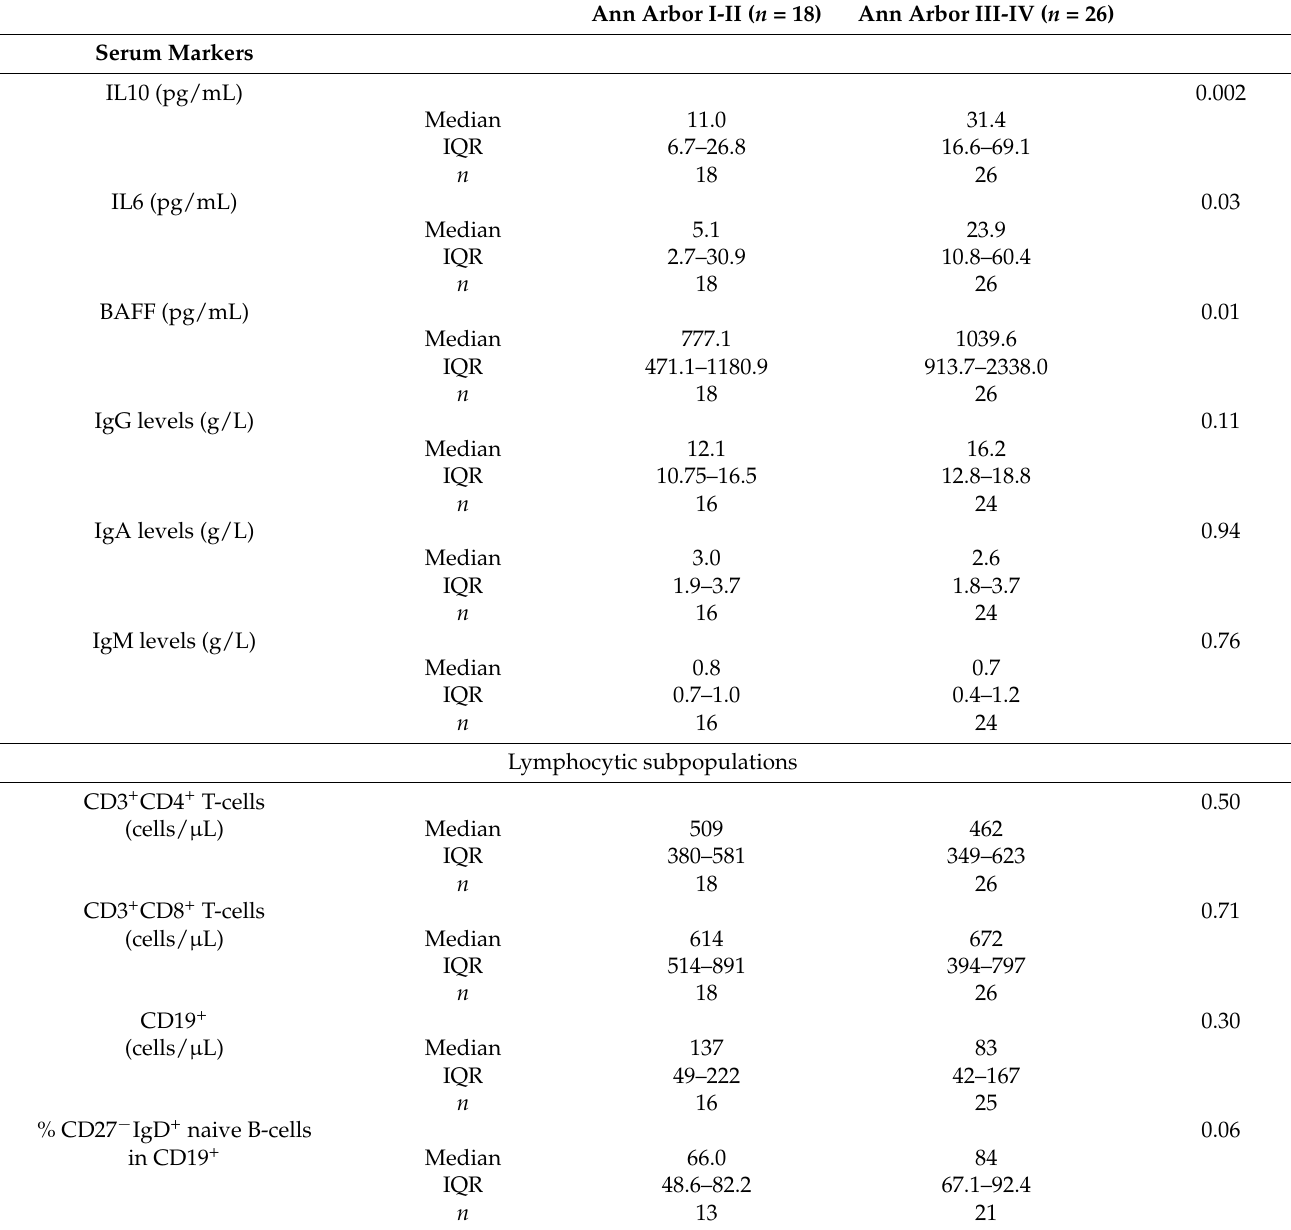
(Table 2). At diagnosis, IL10, IL6 and BAFF cytokine serum levels were higher in cHL patients with advanced-stage (Ann Arbor III-IV) lymphoma compared to patients with localized disease ( p = 0.002, p = 0.03 and p = 0.01, respectively). In contrast, there was no significant difference in IgG, IgA or IgM serum levels according to clinical stage ( p = 0.11, p = 0.94 and p = 0.76) (Table 3). In the 38 patients followed longitudinally, IL10, IL6 and BAFF serum levels decreased during the 24 months following cHL diagnosis ( p < 0.0001, p = 0.02 and p < 0.0001), respectively (Table 4 and Figure 1). Table 3. Serum markers and lymphocyte subsets in HIV-cHL patients according to lymphoma clinical